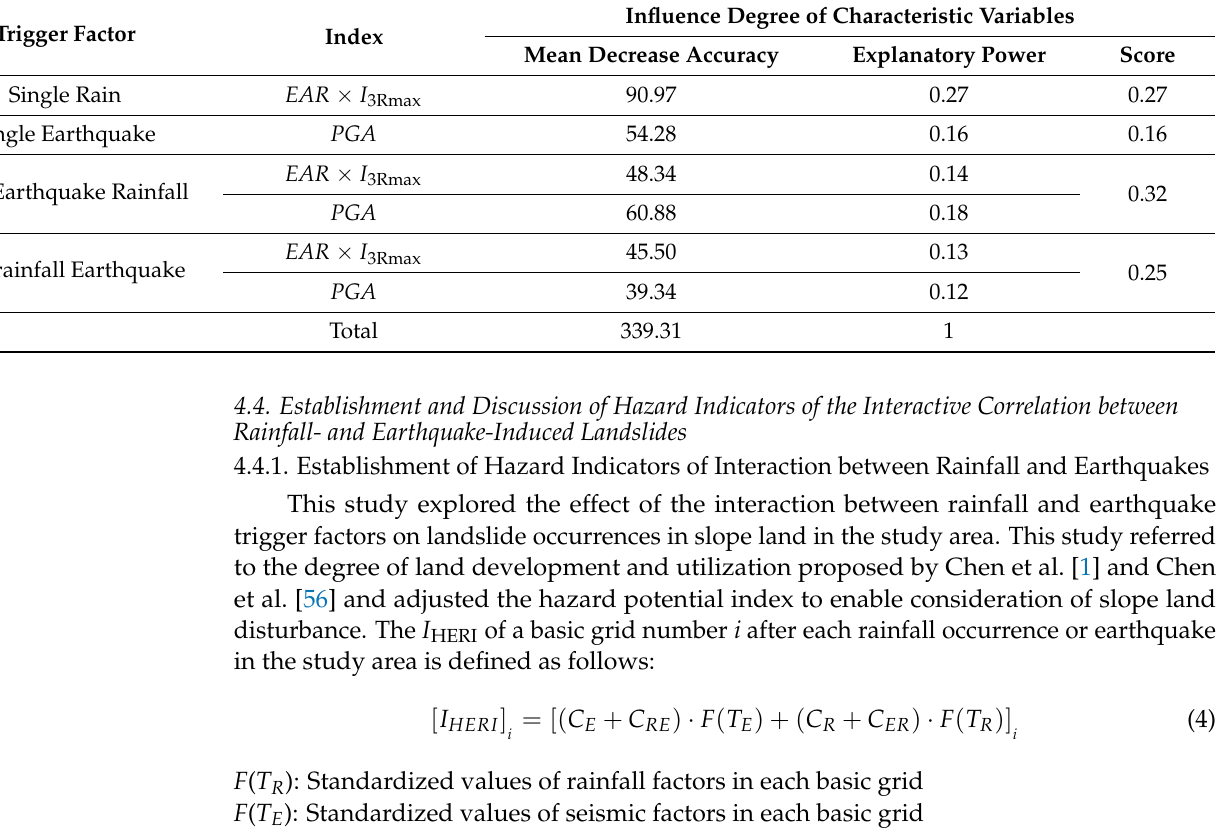
Table 5. Degree of influence of EAR × I 3Rmax and PGA under different trigger